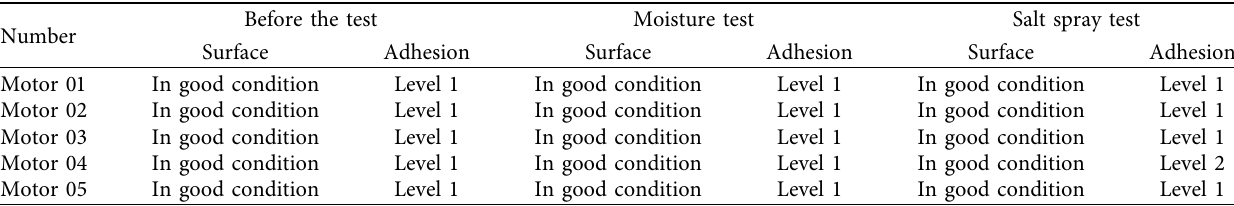
Table 3: Experimental results of moisture resistance and adhesion of nanometre temperature resistant anti-corrosive